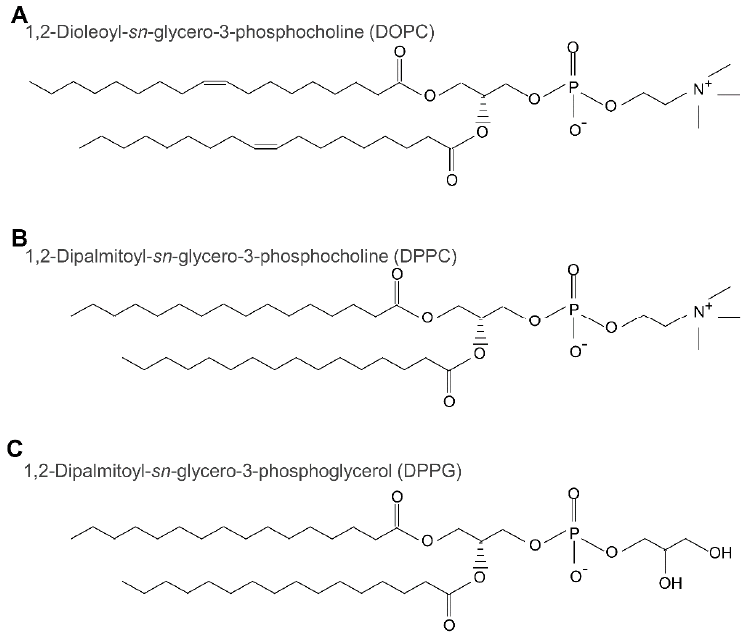
Figure 1. The structures of three lipids: 1,2-dioleoyl- sn -glycero-3-phosphocholine (DOPC, A ); 1,2dipalmitoyl- sn -glycero-3-phosphocholine (DPPC, B ); and 1,2-dipalmitoyl- sn -glycero-3-phosphoglycerol (DPPG, C ).